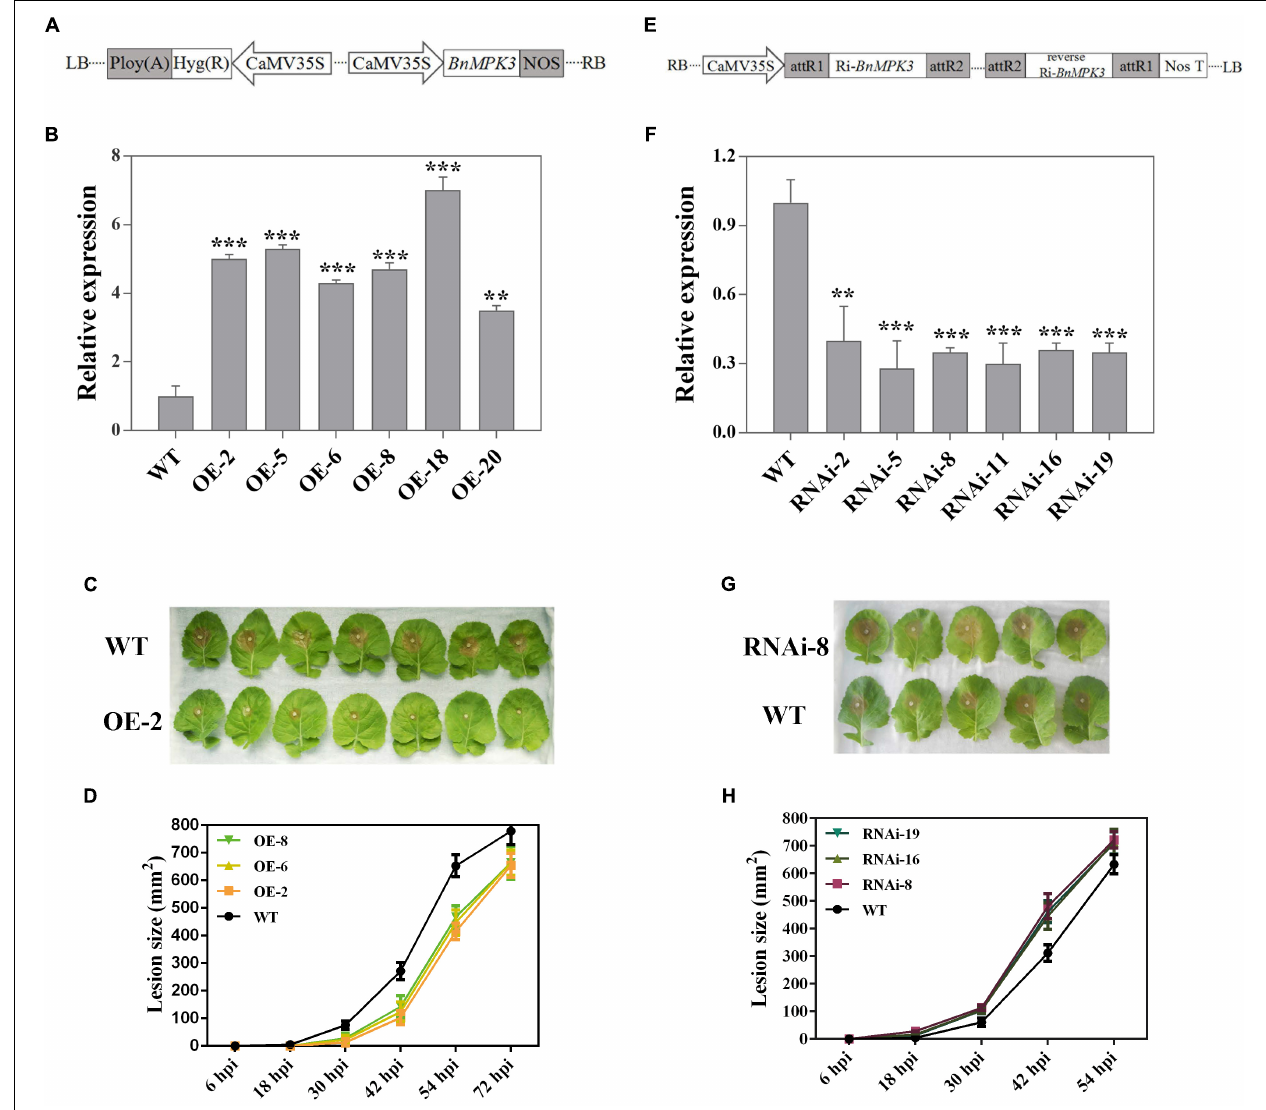
FIGURE 4 | Altered expression of BnaMPK3 results in altered resistance to S. sclerotiorum in oilseed rape. (A) Diagram of T-DNA of the plasmid used in this overexpression analysis. CaMV35S, cauliflower mosaic virus 35S promoter; NOS, terminator. (B) Validation of BnaMPK3 -overexpressing lines at transcription levels revealed by real-time quantitative PCR (qRT-PCR). The significances of the gene expression differences between each BnaMPK3 -overexpressing line and WT are indicated (Student’s t -test, ∗∗∗ P < 0.001, ∗∗ 0.001 < P < 0.01 or ∗ 0.01 < P < 0.05). (C) Disease responses of inoculated plants at 42 hour post-inoculation (hpi). (D) Disease progression is shown from 6 to 72 hpi. Error bars indicate standard deviations. Differences in susceptibility between WT and the transgenic lines were significant ( P < 0.05) from 18 to 54 hpi. (E) Diagram of T-DNA of the plasmid used in this RNAi analysis. CaMV35S, cauliflower mosaic virus 35S promoter; NOS, terminator. (F) Validation of BnaMPK3 -RNAi lines at transcription levels revealed by real-time quantitative PCR (qRT-PCR). The significances of the gene expression differences between each BnaMPK3 -RNAi line and WT are indicated (Student’s t -test, ∗∗∗ P < 0.001, ∗∗ 0.001 < P < 0.01 or ∗ 0.01 < P < 0.05). (G) Disease responses of inoculated plants at 30 hpi. (H) Disease progression is shown from 6 to 54 hpi. Error bars indicate standard deviations. Differences in susceptibility between WT and the transgenic lines were significant ( P < 0.05) from 18 to 42 hpi. WT, untransformed wild-type control; OE-2, -5, -6, -8, -18, -20 are six independent BnaMPK3- overexpressing transgenic lines; RNAi-2, -5, -8, -11, -16, -19 are six independent BnaMPK3- RNA-interfering transgenic